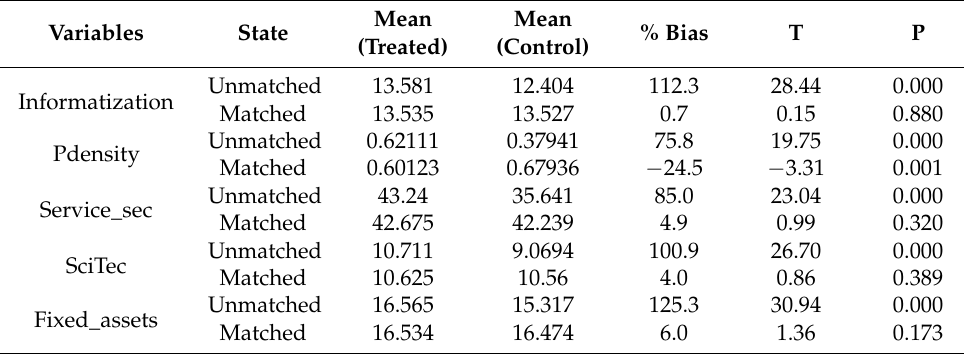
Table 5. Reduced bias in the covariates after matching.